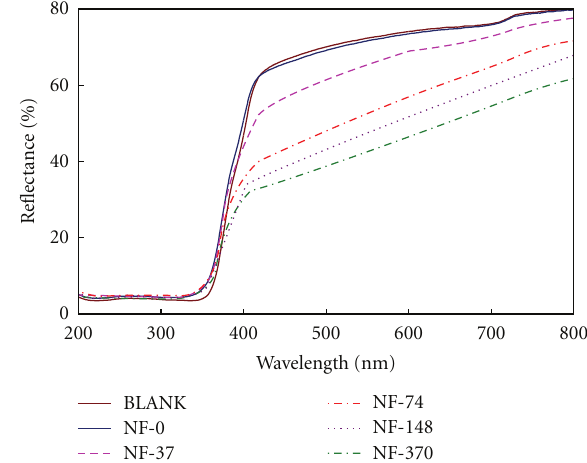
Figure 4: E ff ect of NH 4 F concentration on the UV-Vis-DRS of the NF series catalysts (NF-0, NF-37, NF-74, NF-148, and NF-370 represent the NF series catalyst calcined in the presence of NH 4 F; the dosages of NH 4 F were 0, 0.37, 0.74, 1.48, and 3.70 g, resp.; the sample BLANK was the raw TiO 2 directly calcined without milling